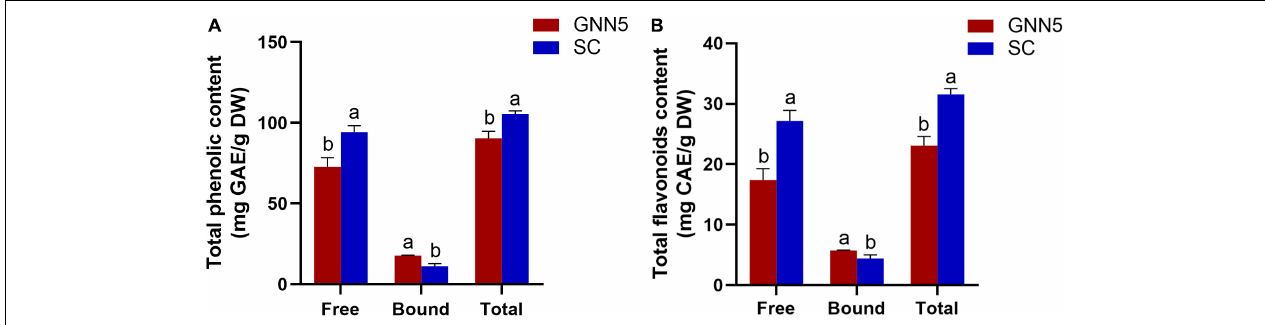
FIGURE 1 | Total phenolic contents (A) and total flavonoid contents (B) of free and bound phenolic fractions extracted from two R. roxburghii leaves. Data represent the mean values ± SD ( n = 3), and different letters indicate significant difference ( p < 0.05) between two cultivars. Total, the sum of free and bound fractions.